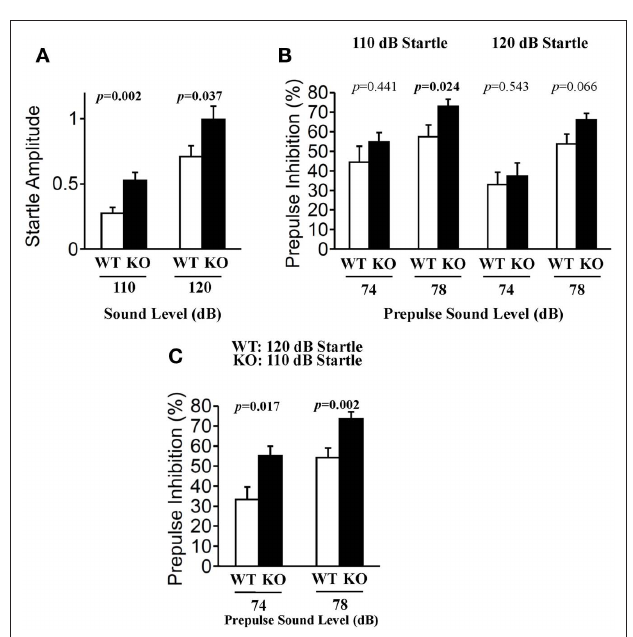
Figure 7 | Social interaction in a novel environment. Total duration of contacts (A) , number of contacts (B) , total duration of active contacts (C) , mean duration of each contact (D) , and total distance traveled (e) were recorded. p -Values were calculated by Student’s t -test.